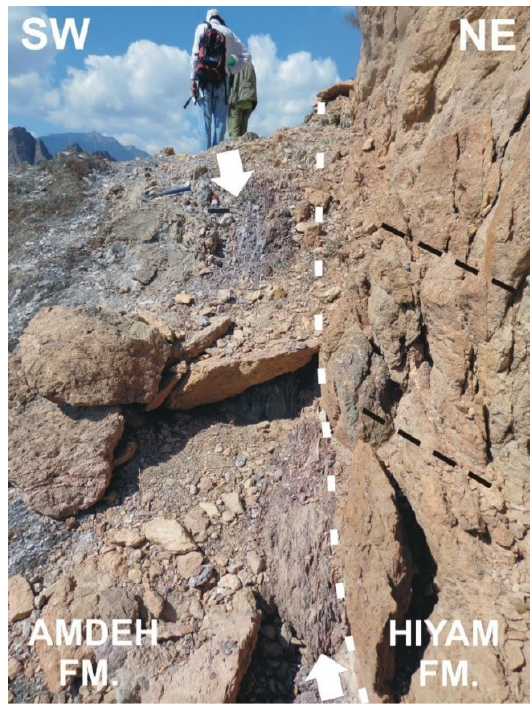
Figure 13. Contact between the Amdeh and Hiyam formations. The contact is marked by the sinistral Wadi Amdeh Fault (dashed white line). Note the slickenlines between the two black dashed lines. The two white arrows point to the red cataclasite / tectonic breccia in close proximity to the fault. Note that the red cataclasite / tectonic breccia is obliquely oriented to the fault, being in contact with the fault in the foreground and separated from the fault in the background. Coordinates of the fault: 23 ◦ 19 (cid:48) 45.12”N / 58 ◦ 23 (cid:48) 43.95”